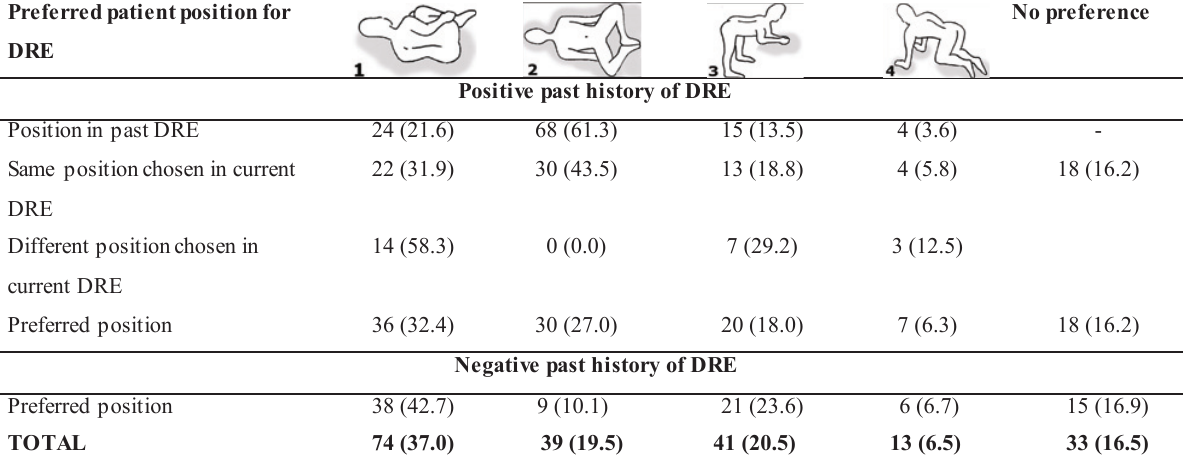
Table 1 - Patient positioning in past DRE, and patients’ preferences in current DRE .